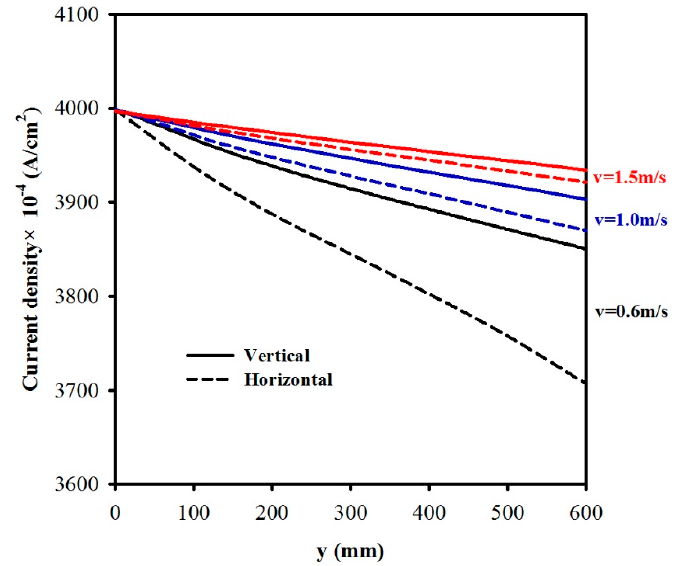
Figure 8. A comparison of current density distribution along the electrode y for a vertical cell and a horizontal cell, with three different v in = 0.6, 1.0, and 1.5 m/s.